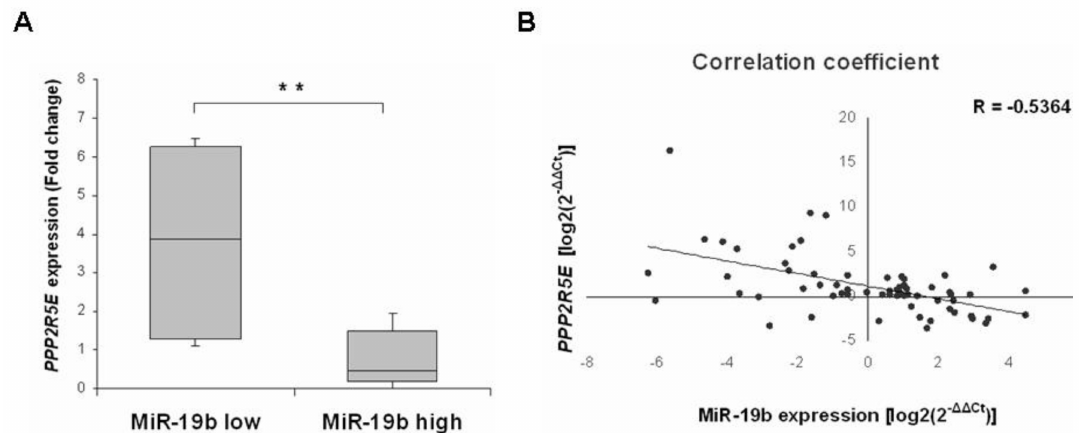
Figure 3. Evaluation of the miR-19b/PPP2R5E axis in LARC; ( A ) Box-plot showing PPP2R5E levels in LARC patients with low and high miR-19b expression; ** p < 0.001; ( B ) Scatter plot showing the negative correlation between miR-19b and PPP2R5E expression in 63 LARC